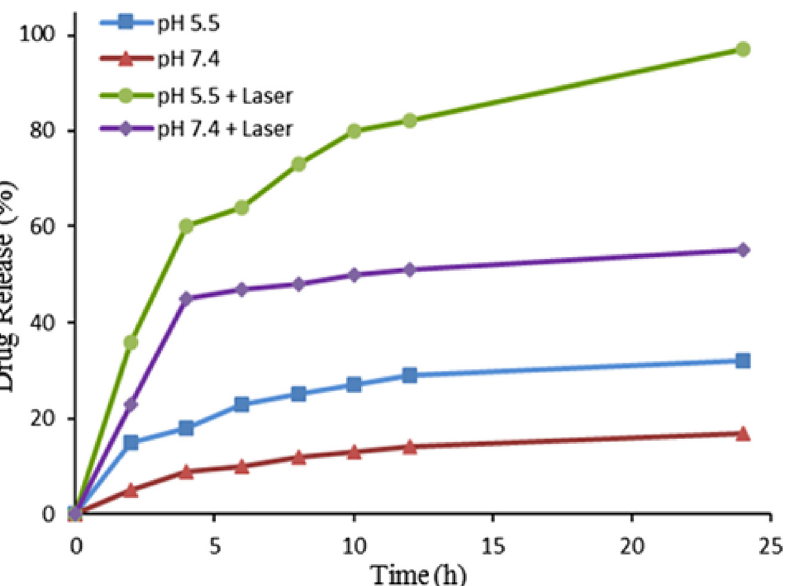
Figure 11: Cumulative DOX release from GNRs@SBA-15-SH/DOX nanocomposite with and without NIR laser irradiation at different pH